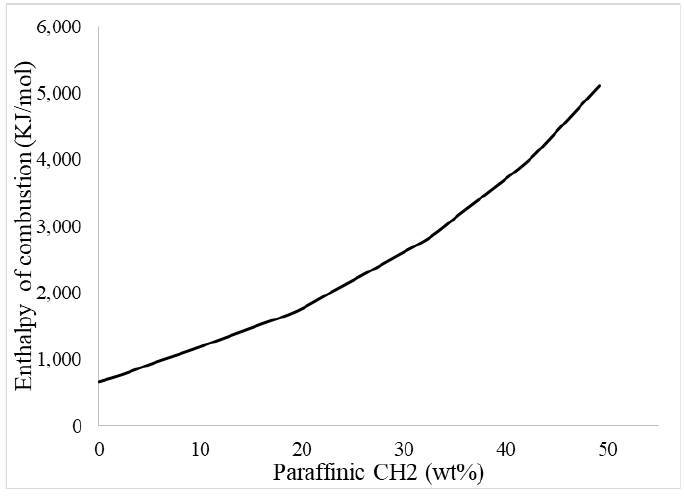
Figure 2. The effect of weight percentage of CH2 on enthalpy of combustion for iso-paraffins.